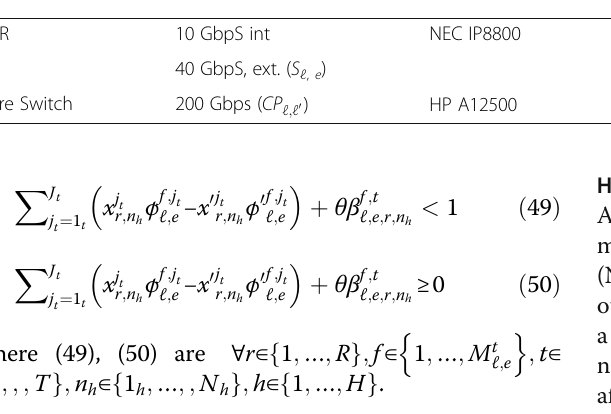
Table 6 Characteristics of Typical Switches Switch Type Interface data